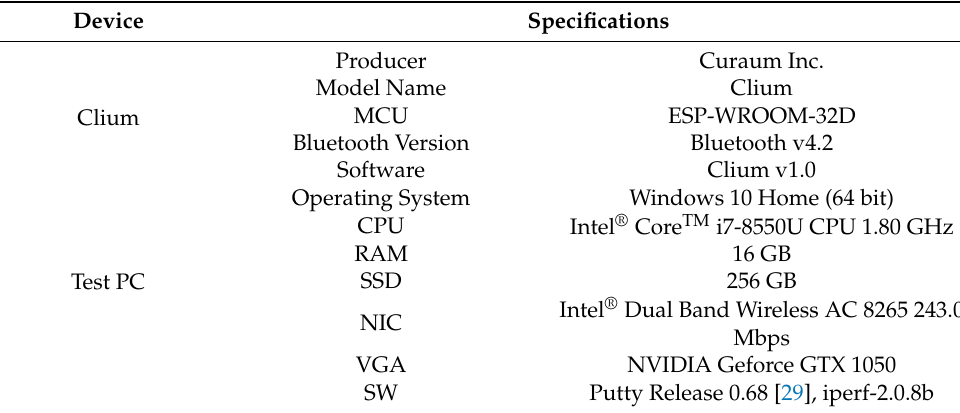
Table 3. MAD cleaner communication gateway and test PC specifications.